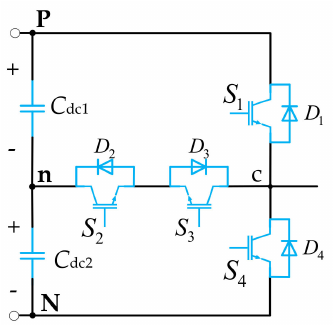
Figure 5. PR T-type converter